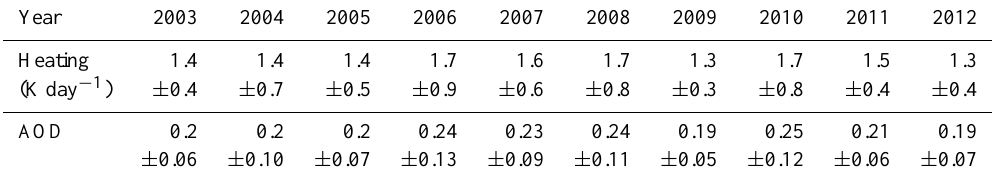
Table 4. Summertime observed approximated heating rate [d T /d t ± standard deviation] within the aerosol layer and MODIS-AOD ( ± standard deviation) over the ROI in the eastern Mediterranean basin for 10 years